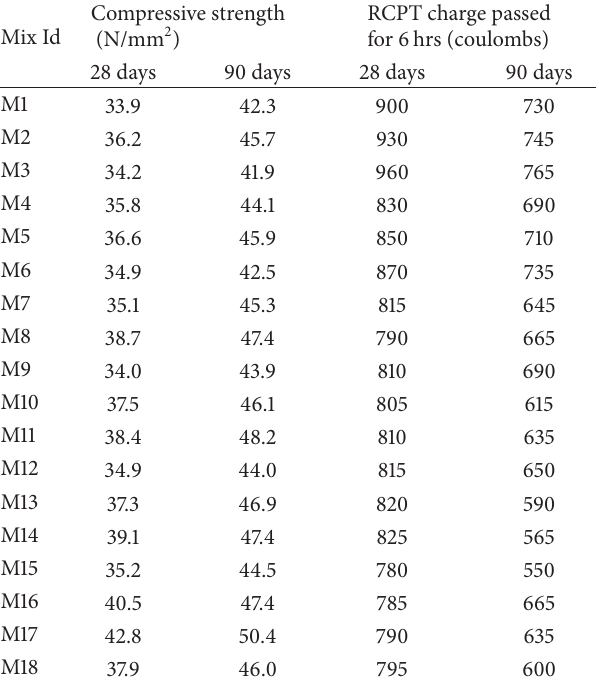
Table 2: Compressive strength and rapid chloride permeability test values for different concrete